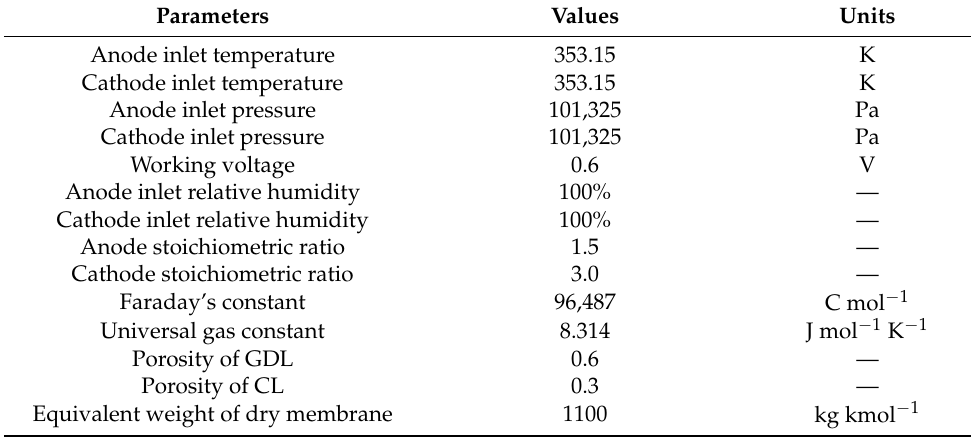
Table 2. Operating conditions and material or physical properties of PEMFC of the CFD